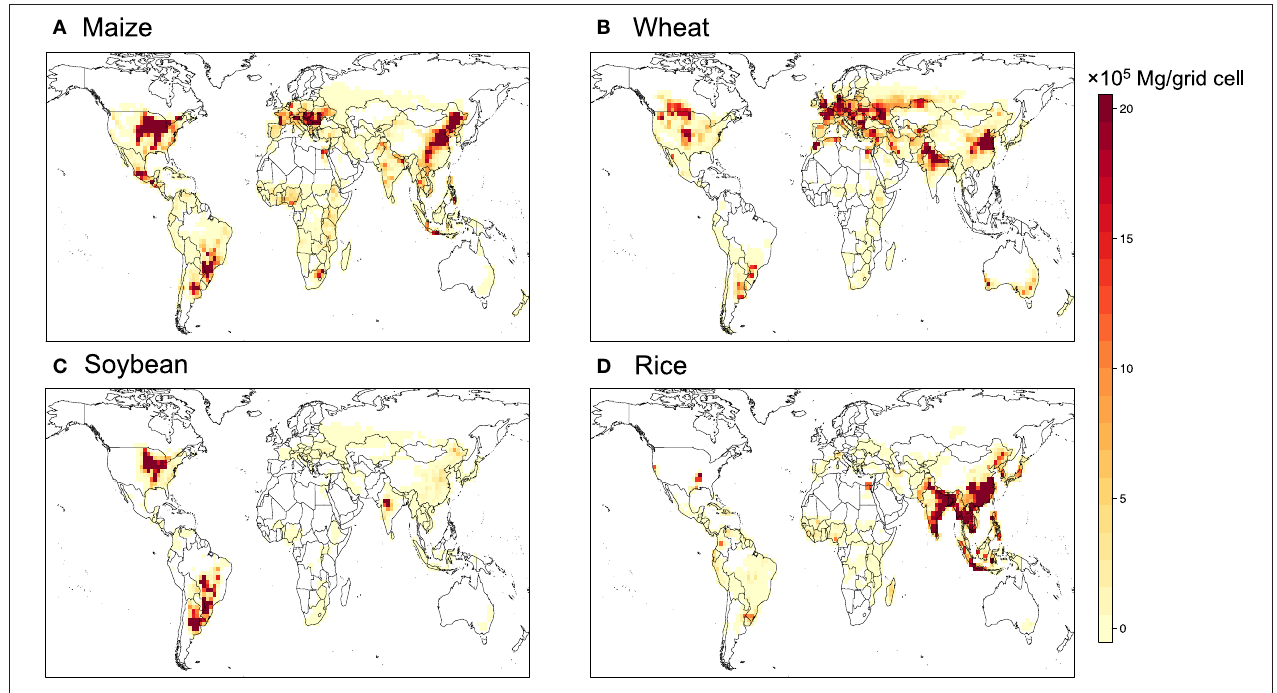
FIGURE 1 | Crop production for (A) maize, (B) wheat, (C) soybean, and (D) rice averaged over 2006–2010, shown only when production > 500 Mg per grid cell.